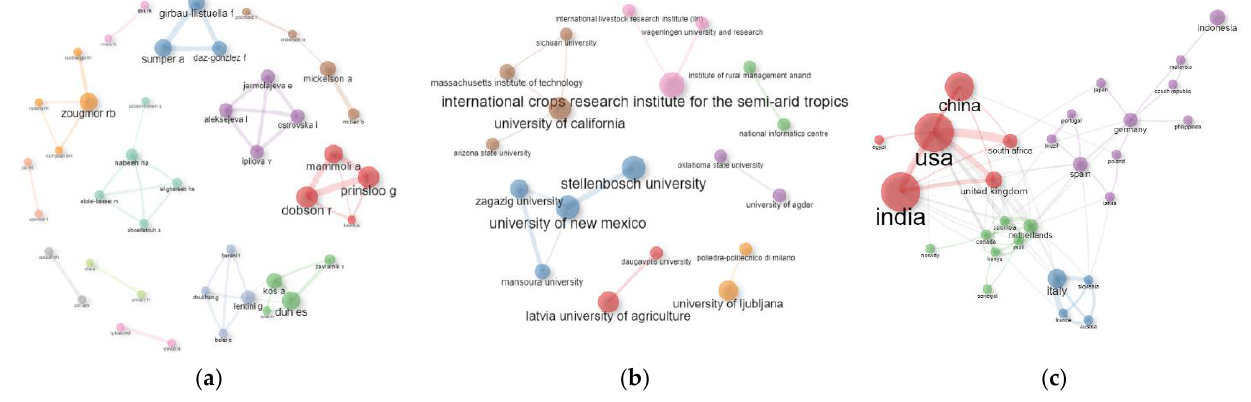
Figure 4. Collaboration networks between authors, institutions, and countries. ( a ) Authors; ( b ) Institutions; ( c ) Countries.